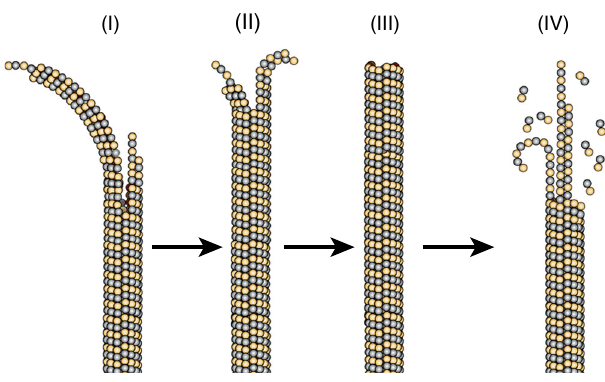
Fig. 5 Model for growth and shrinkage for axonemal tubulin. (I) MTs polymerize by incorporation of GTP-tubulin at their tip. During this process PFs form curved tip structures with a radius of curvature of ~400